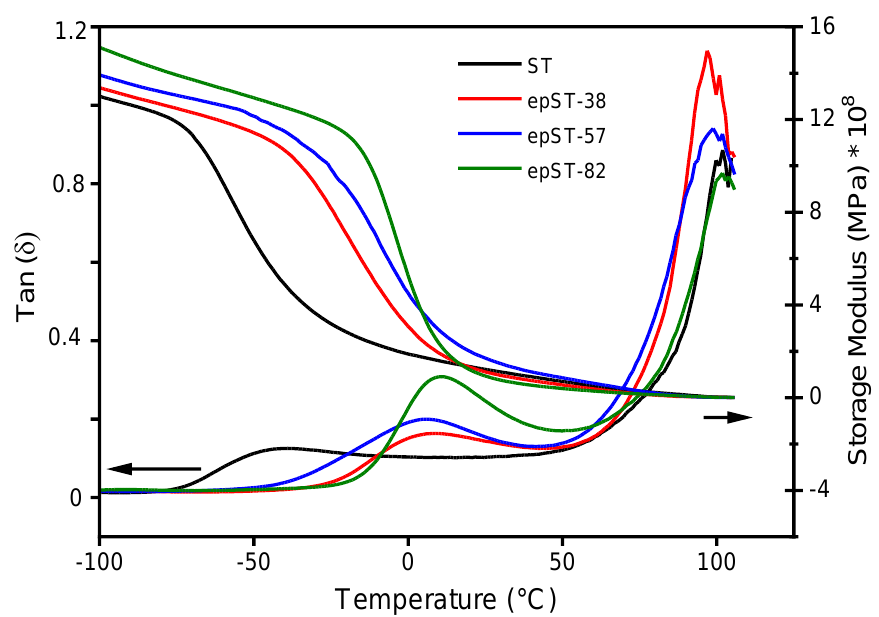
Figure 8. Loss factor tan δ (left) and storage modulus G′ (right) versus temperature of virgin ST and epST-x.